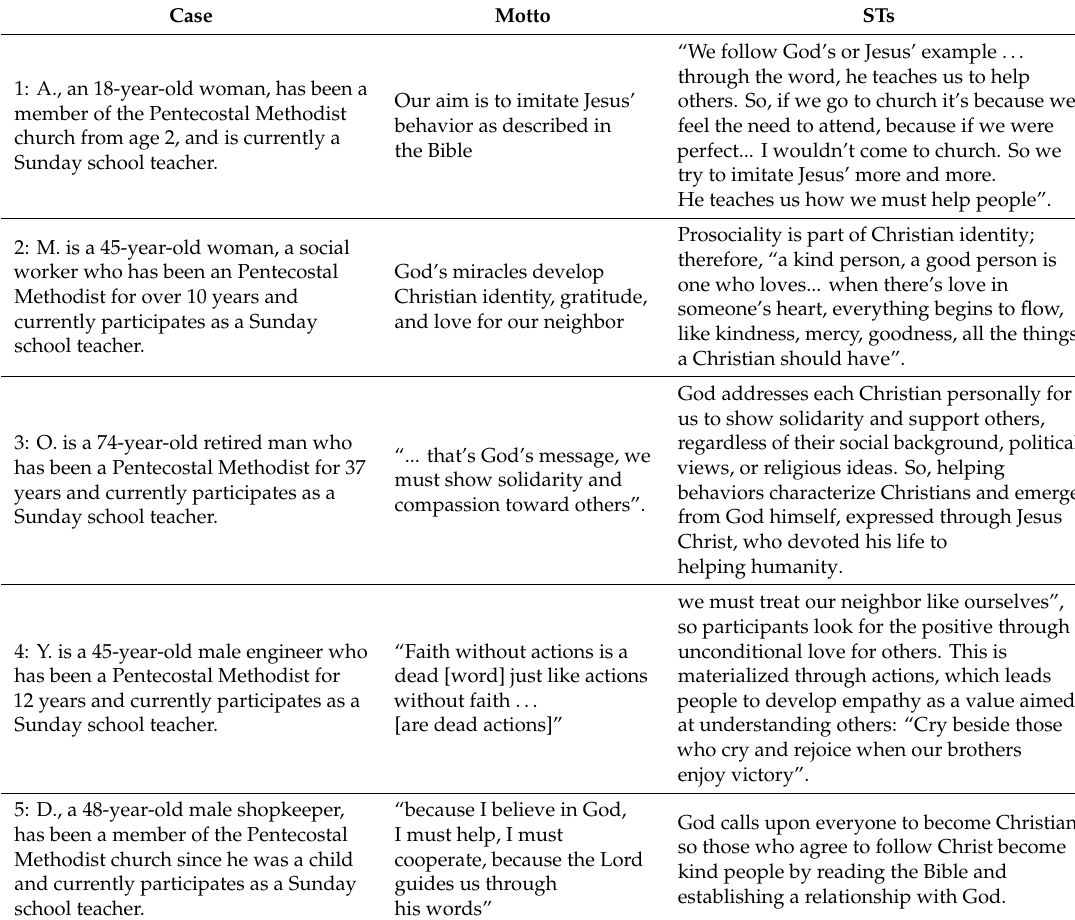
Table 2. Intra-case